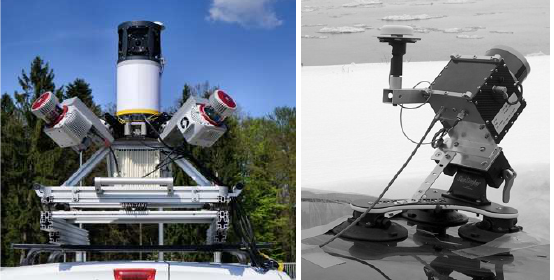
Figure 2: Riegl/IGI sensors (back) and PuckLite/APX15 (front)